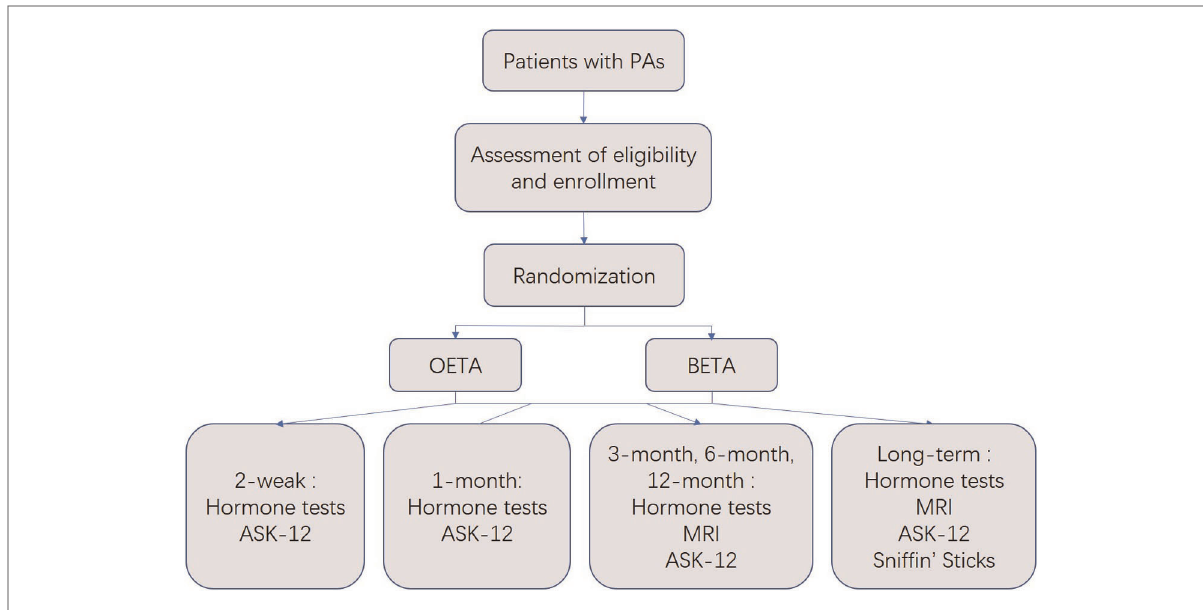
FIGURE 1 Flowchart of the trial. Anterior Skull Base Nasal Inventory-12, ASK Nasal-12; binostril endoscopic transsphenoidal approach, BETA; one-and-a-half nostril endoscopic transsphenoidal approach, OETA; pituitary adenomas, PAs.